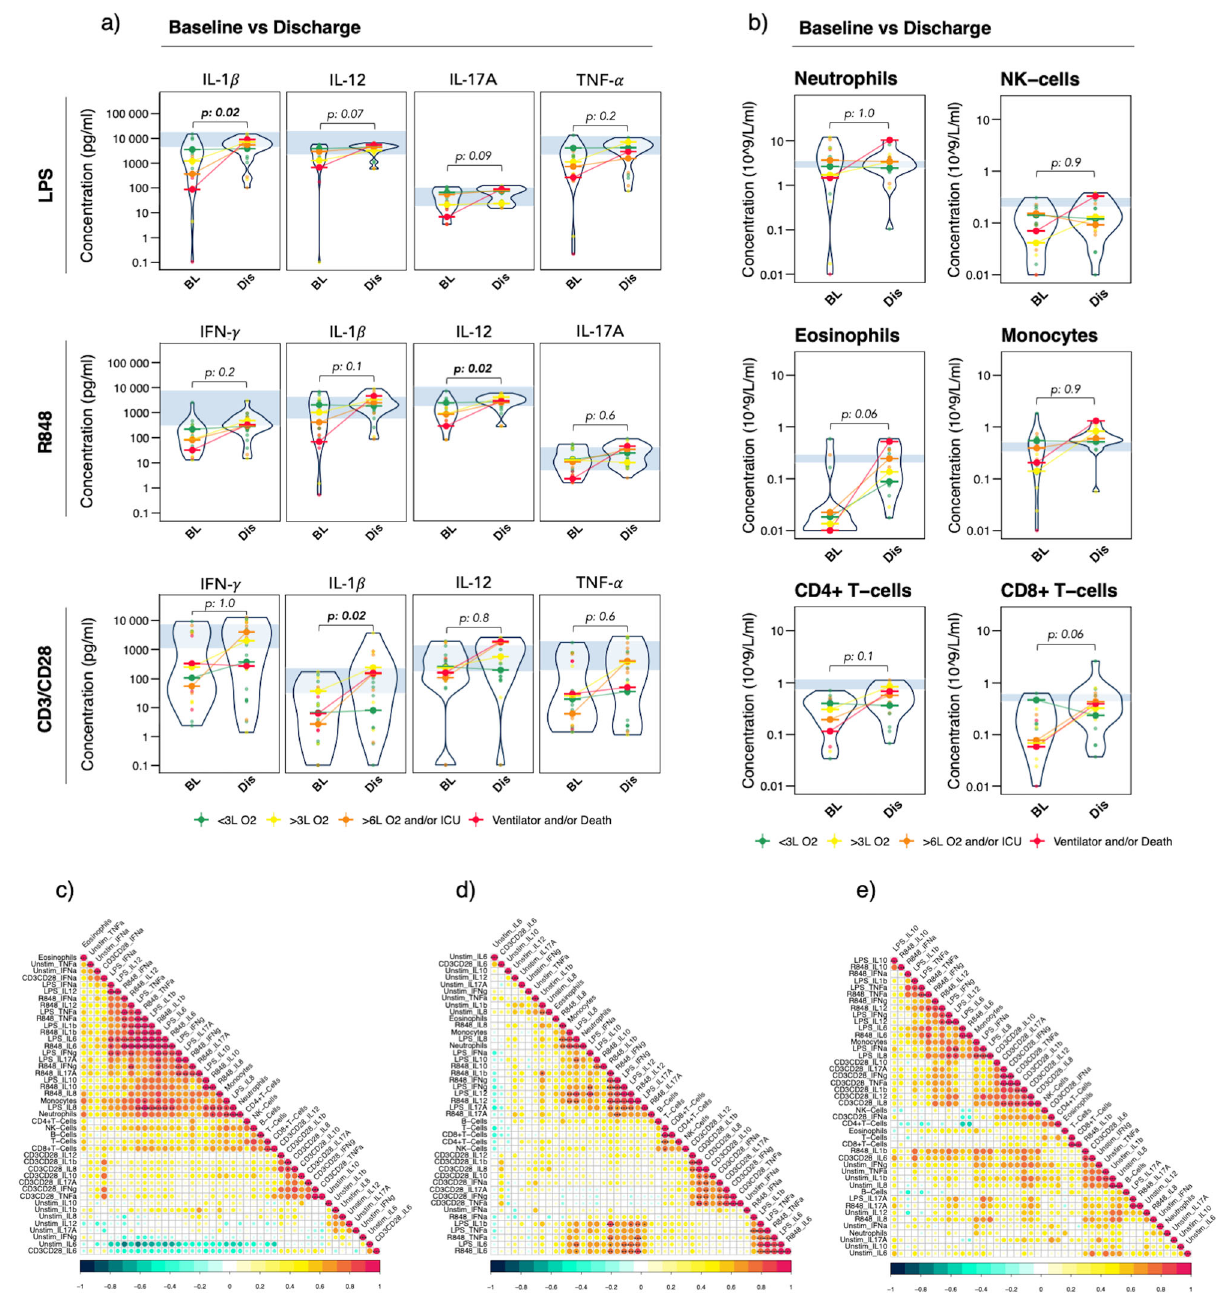
Fig. 3 Stimulated immune responses and immune cell constitution at discharge vs baseline, and correlation between immune cell subsets and stimulated immune responses. a , b Violin plots displaying concentration levels for ( a ) a subset of cytokines in response to LPS, R848, and CD3/CD28 at discharge ( n = 25, except for CD3/CD28: n = 24) vs baseline ( n = 23 except for CD3/CD28: n = 21), and b immune cell subsets at discharge ( n = 18) vs baseline ( n = 28). Solid dots represent individual patient measurements, colored by peak severity group; green = Grade 1, yellow = Grade 2, orange = Grade 3, red = Grade 4. Medians within each severity group at discharge and baseline are connected with a line, colored by peak severity. Data at baseline vs discharge were compared using the Wilcoxon signed-rank test, only including patients with paired baseline- and discharge samples available ( n = 18 for immune responses, n = 8 for immune cell constitution). Adjustment for multiple testing was done using Bonferroni and adjusted p < 0.05 was considered statistically signi fi cant. c – e Correlation matrices of 8 immune cell subsets and 45 TruCulture cytokine variables by Pearson at c baseline, d at/ near peak severity, and e discharge. All data were log-transformed cytokine concentrations. Correlation coef fi cients are visualized by color intensity. Only statistically signi fi cant correlations after Bonferroni adjustment are presented;* adjusted p < 0.05, ** adjusted p < 0.01, *** adjusted p < 0.001. BL baseline, Dis discharge, LPS lipopolysaccharide, R848 resiquimod, CD cluster of differentiation, IFN interferon, IL interleukin, TNF tumor necrosis factor, NK natural killer, L O2 liters/minute of oxygen supply, ICU intensive care unit, Unstim no